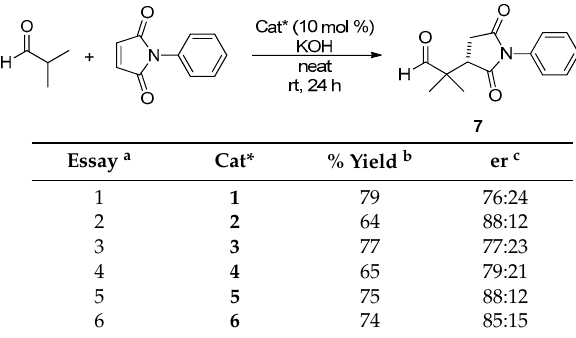
Table 1. Michael addition reaction of isobutyraldehyde to N -phenylmaleimide organocatalyzed by α , β -dipeptides 1 – 6 .